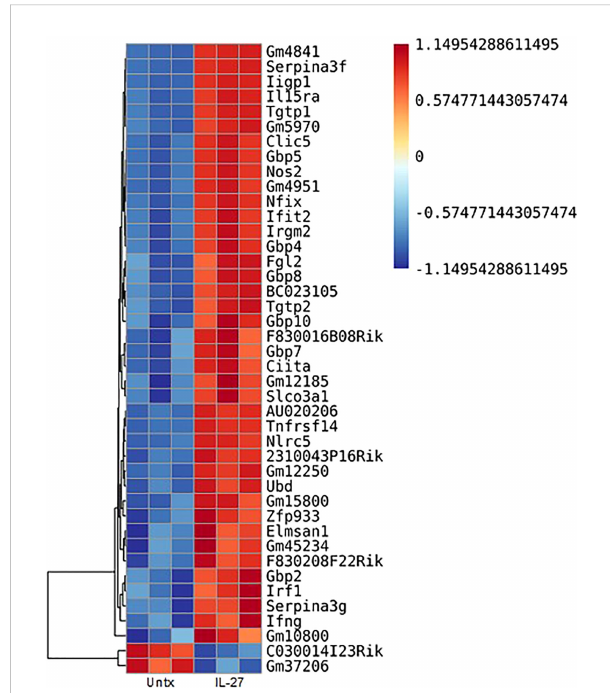
FIGURE 2 Transcripts in murine macrophages affected by IL-27 stimulation. Thioglycolate-induced peritoneal macrophages were cultured with 100 ng/ml IL-27 for 24h. Shown are 42 transcripts that were signi fi cantly changed by IL-27 stimulation. All data are representative of a minimum of at least three independent experiments. P<0.05. Graph depicts mean +